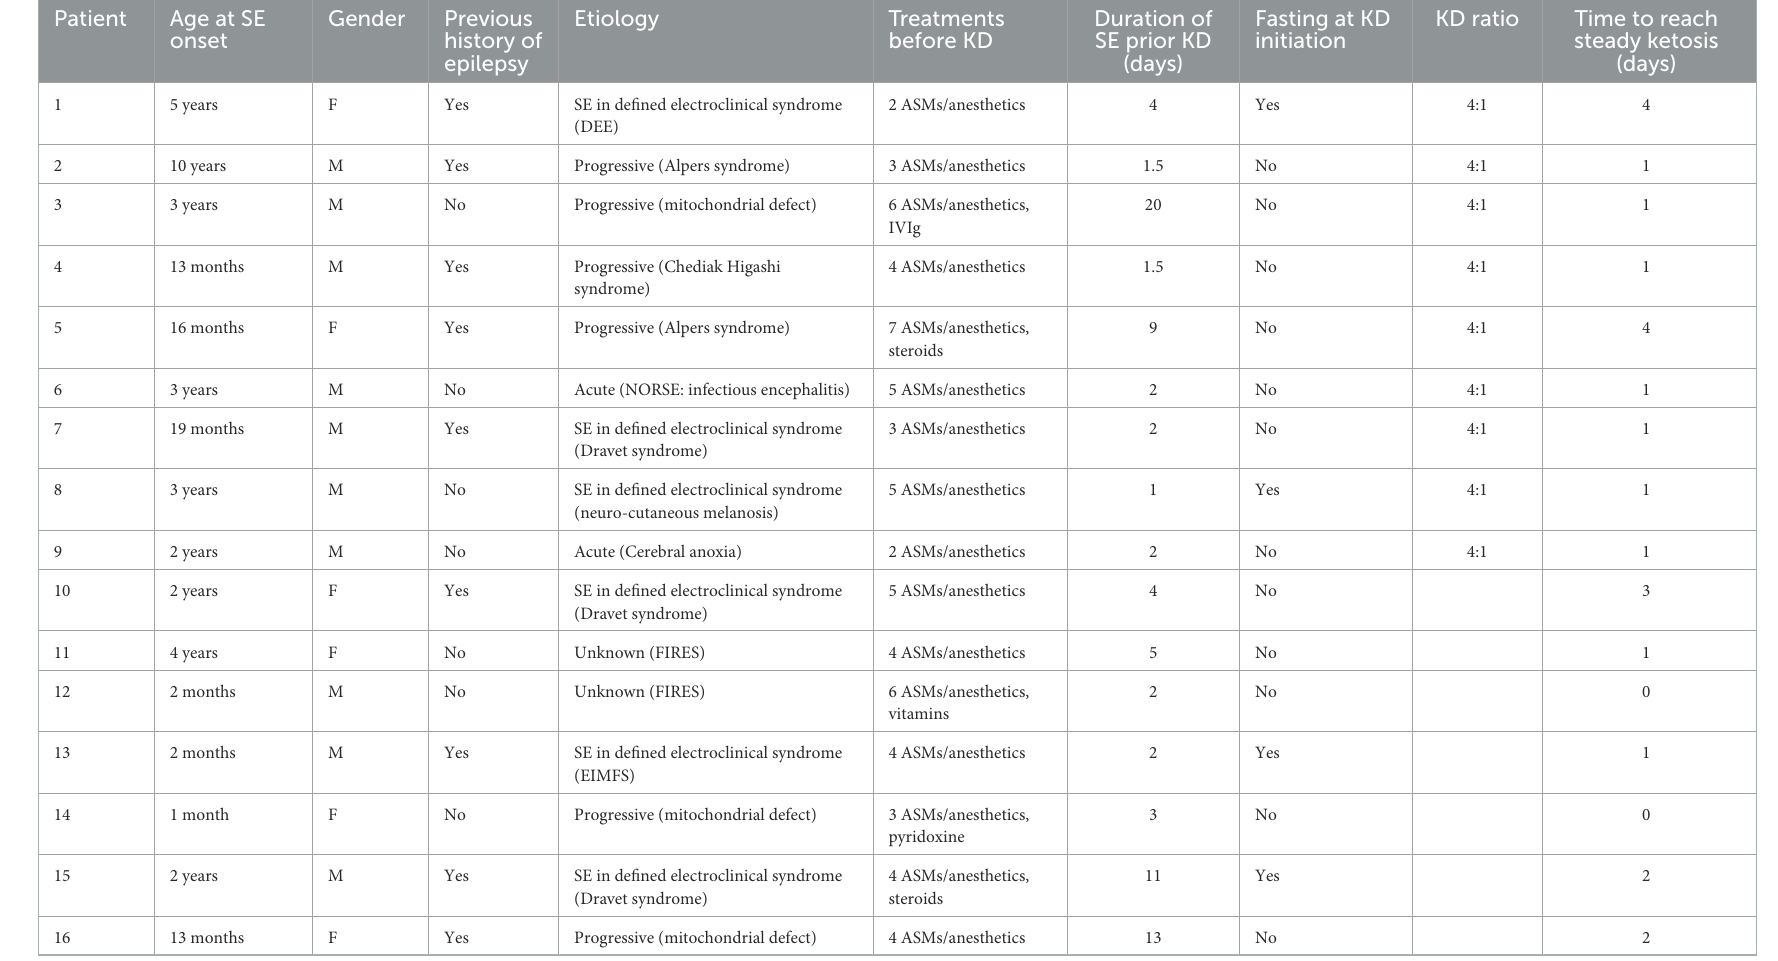
TABLE 1 Necker Enfants Malades Hospital experience: patients’